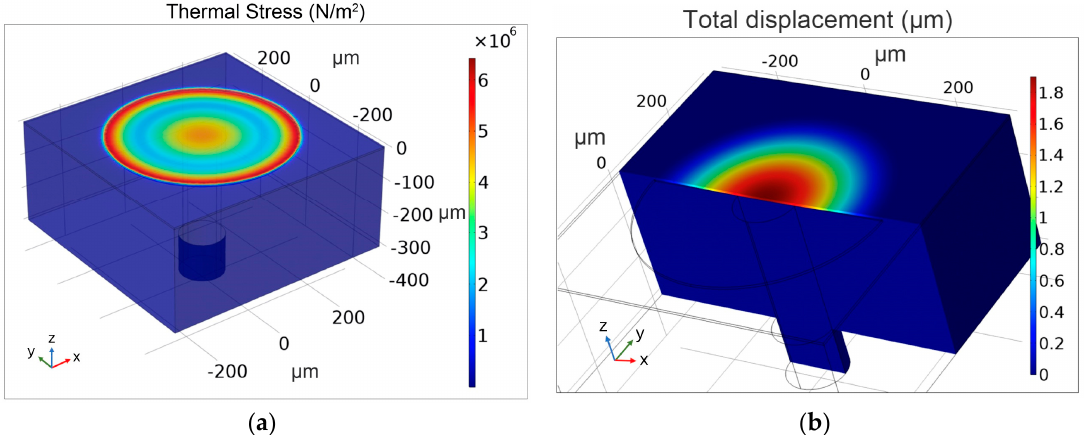
Figure 2. Simulation results for ( a ) thermal stress and ( b ) thermal expansion of the sensor head.